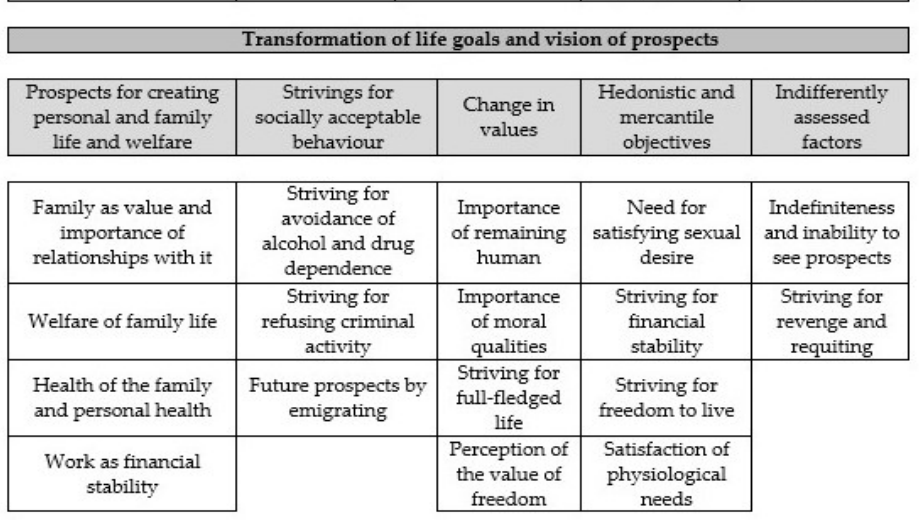
Figure 1. Latent structure of self-evaluation of criminal activity and future prospects of persons serving a custodial sentence.